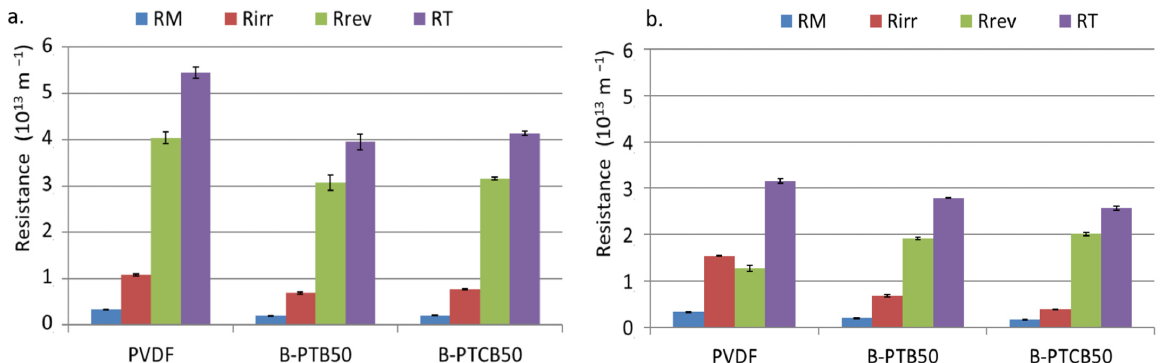
Figure 5. Filtration resistances of PVDF, PTB50, and PTCB50 membranes for real dairy wastewater, using unfiltered ( a ) or pre-filtered (0.2 µm filter paper) wastewater ( b ).